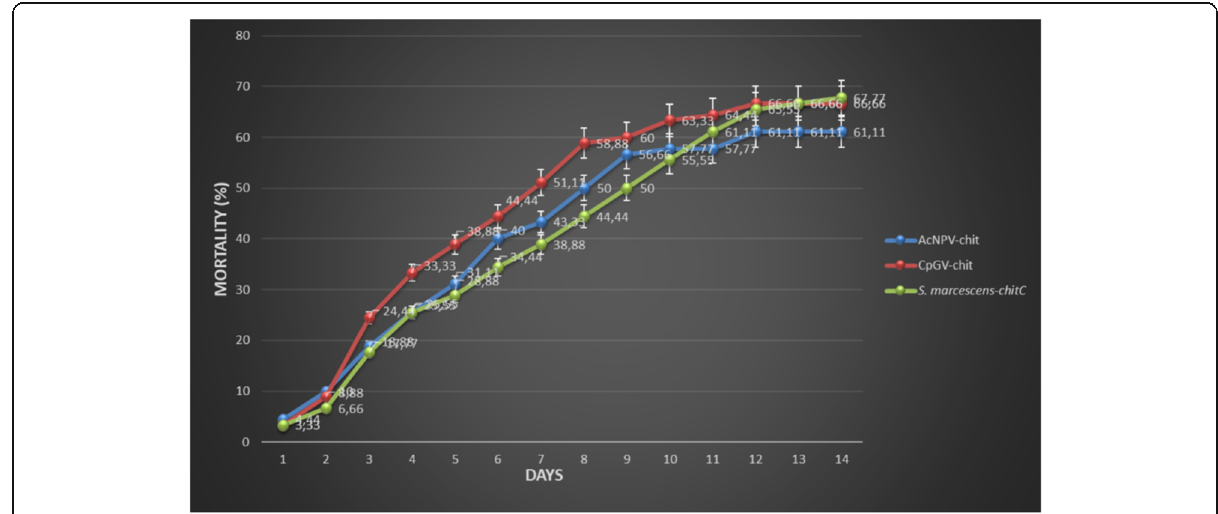
Fig. 6 Mortality rates of purified AcNPV-Chi, CpGV-Chi, and Serratia marcescens -ChiC proteins on Galleria mellonella larvae depending on time. Mortality rates were carried out using the 2.5 μ g per larvae protein concentration